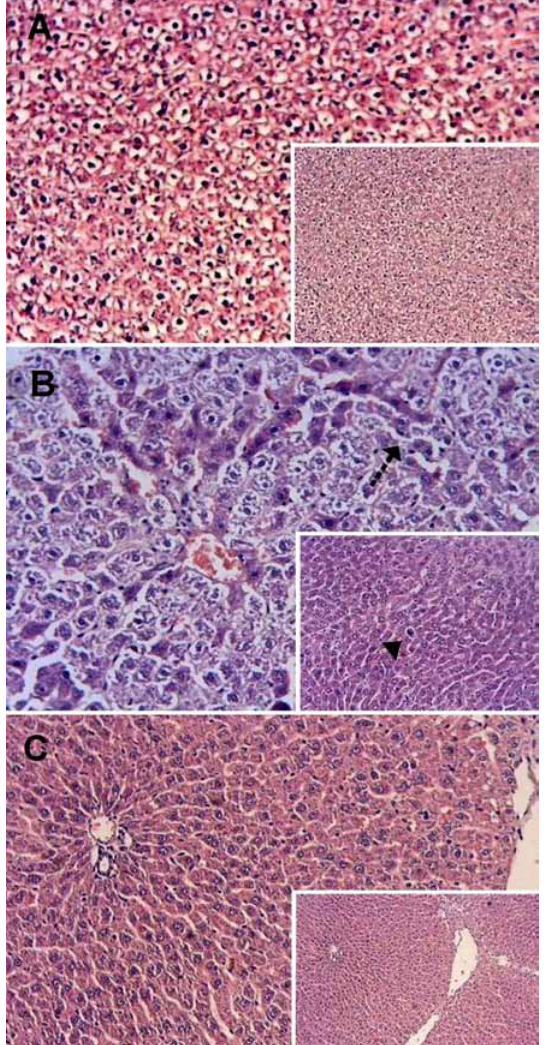
Figure 1. Effect of melatonin on burn-induced histomorphologi- cal changes in liver in rats: A) vehicle treated rats without burns (C)–normal morphology of liver tissue; B)–vehicle treated rats with burns (B)–vacuolization in hepatocytes and acidophil degeneration --- ► , Counselman’s body ► and severe vascular congestion. c) melatonin treated rats with burns (B+Mel)–reduced damage in hepatic paren- chyma. H & E staining, original magnification, 200X, 400X